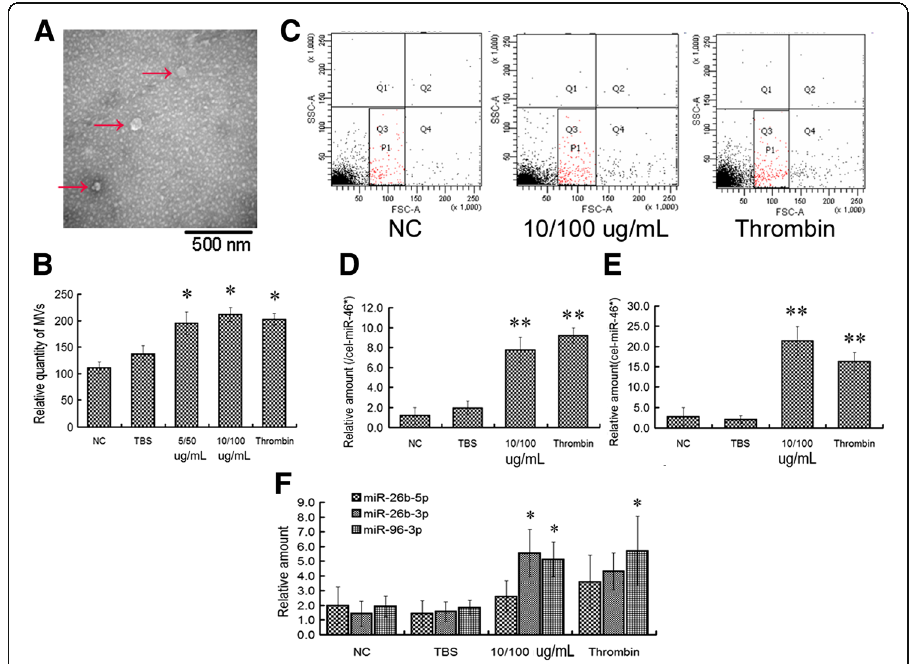
Fig. 1 Anti- β 2GPI/ β 2GPI complex induced the release of platelet-derived microparticles (MPs) and miRNAs. a Representative image of isolated MPs observed via transmission electron microscopy. Three MPs are indicated with arrows. b and c The amount of MPs with thrombin, the antibody complex or the control (TBS or NC) in the P1 area was detected using flow cytometry. MP gates were constructed via flow cytometry using size- calibrated beads. d and e The level of miR-96 ( d ) or miR-26a ( e ) in platelet-derived MPs was measured using quantitative RT-PCR. Cel-miR-46* was used as the internal control. f The relative levels of miR-26b-3p, − 26b-5p and − 96-3p in the p-MPs were detected using quantitative RT-PCR. The results are presented as mean±SD of four independent experiments (* p <0.05, ** p <0.01 vs. TBS